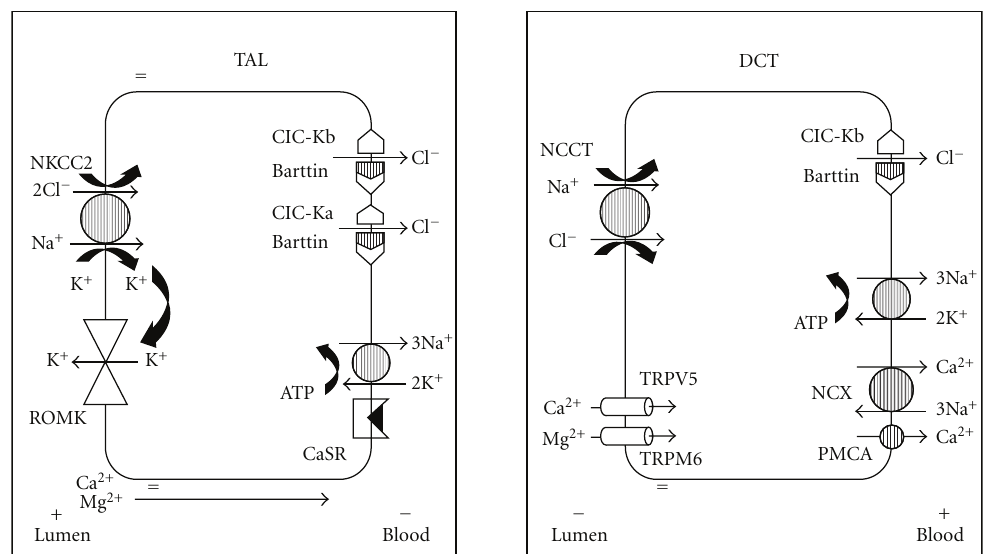
Figure 2: Pictorial representation of ion transporters in thick ascending limb of Loop of Henle (TAL) and distal convoluted tubule (DCT).